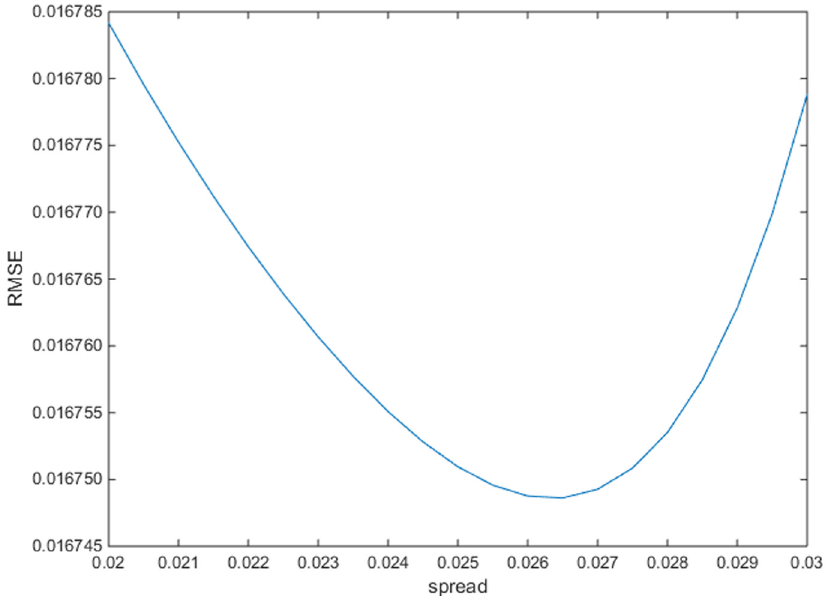
Fig 3. The selection of the optimal spread of the ARIMA-GRNN hybrid model. When the spread was 0.006, the RMSE for the testing samples is the least.